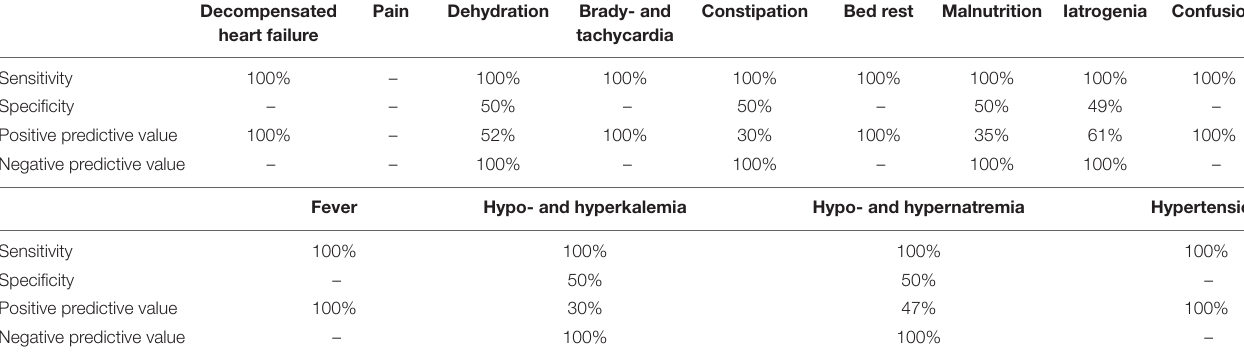
TABLE 4 | Sensitivity, specificity, positive and negative predictive values for alerts from the MyPrediTM remote monitoring platform.